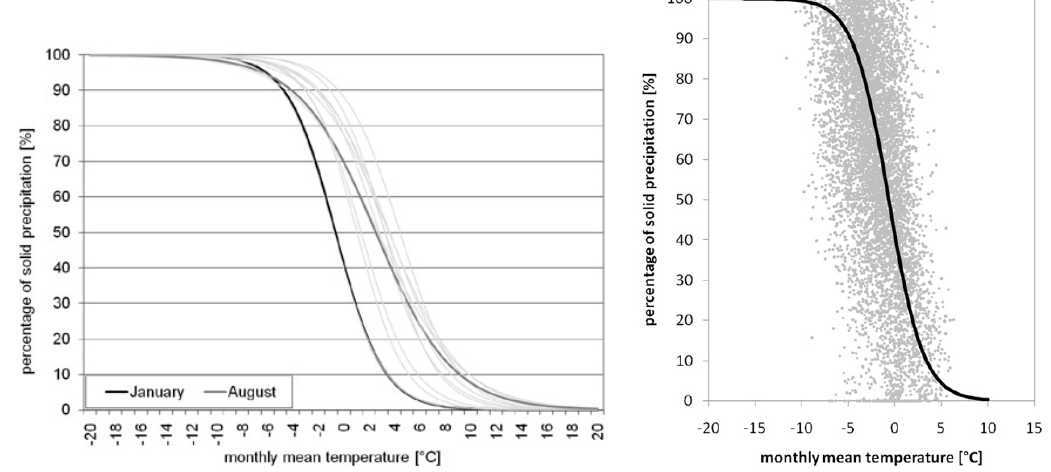
Figure 1. Left: Hyperbolic tangent function describing the relationship between the monthly mean temperature [ ◦ C] (abscissa) and the percentage of solid precipitation [%] (ordinate) for January (black line) and August (dark grey line). Thin light grey lines show the functions for all the other months. Right: Example of the function fitting for January. The black line shows the fitted function and the grey dots the measurements.